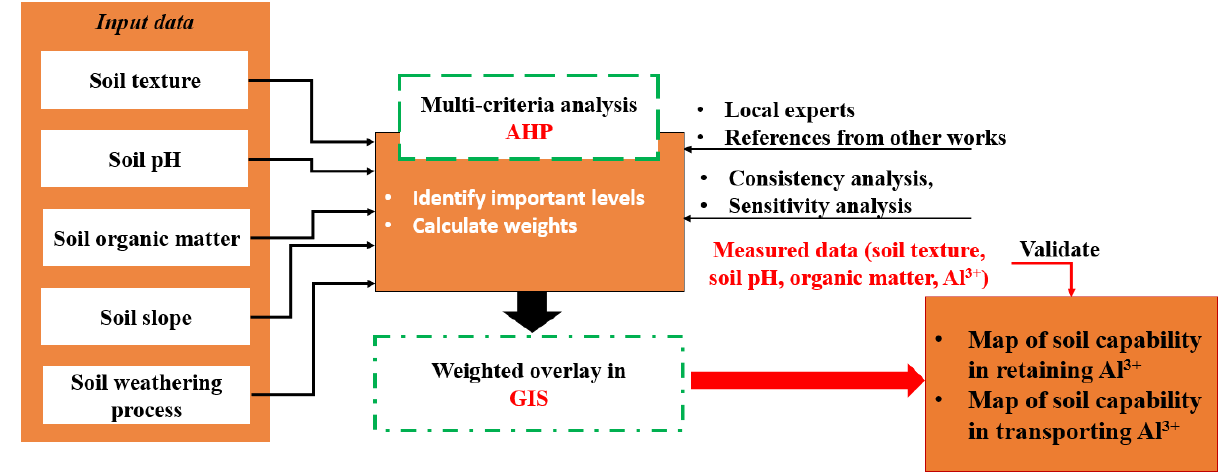
Figure 2. Workflow diagram describing the methodology used in the study.